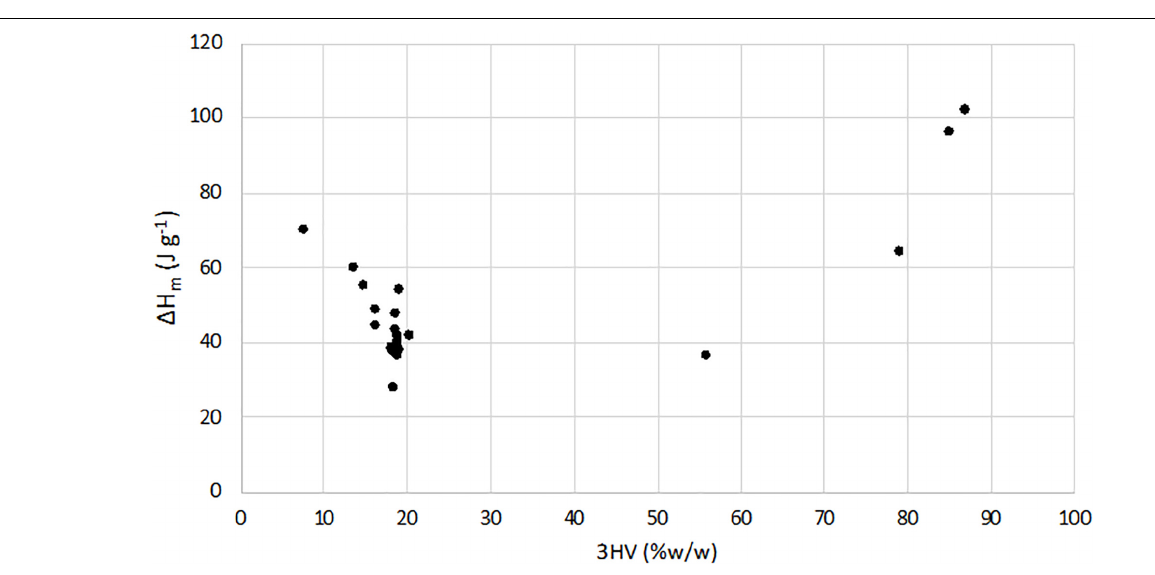
FIGURE 2 | Relationship between (cid:49) H m (J g − 1 ) and monomeric composition (3HV